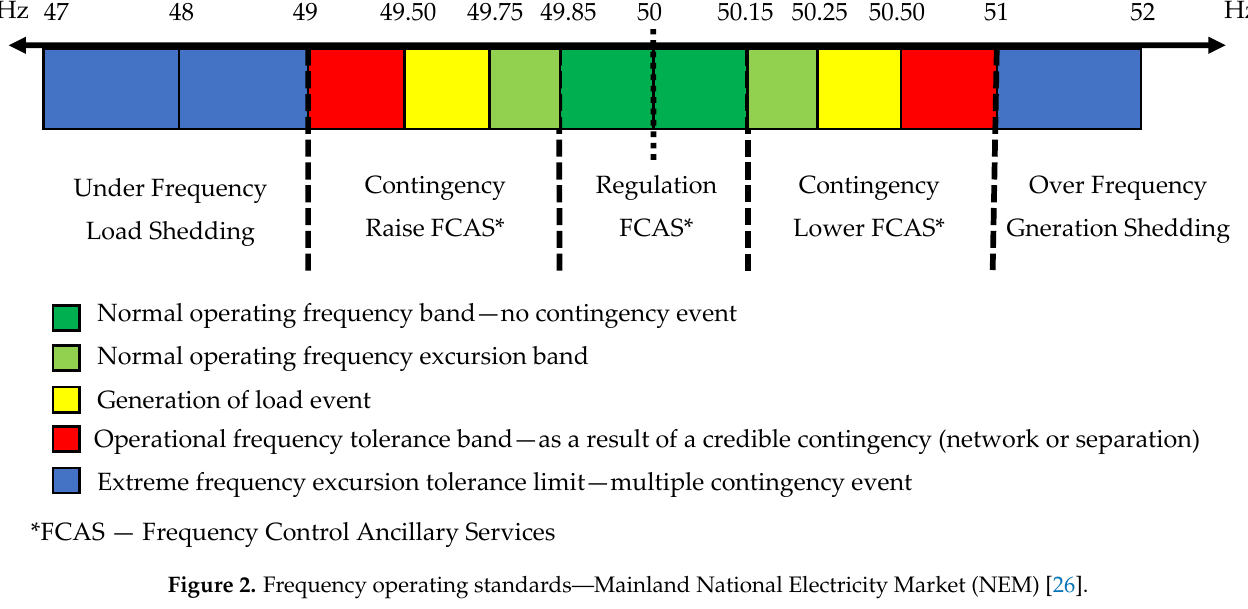
Figure 2. Frequency operating standards—Mainland National Electricity Market (NEM) [26].